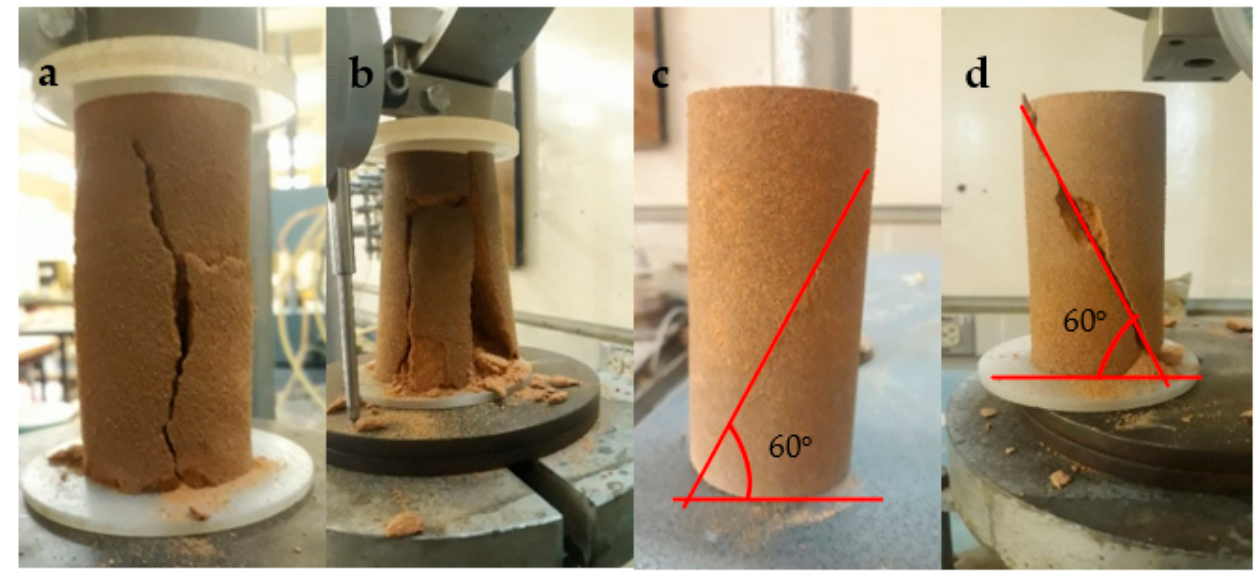
Figure 4. Failure planes for ( a ) control, ( b ) 5% Acacia, ( c ) 5% Sodium alginate, and ( d ) 5% Pectin, after a curing period of seven days.